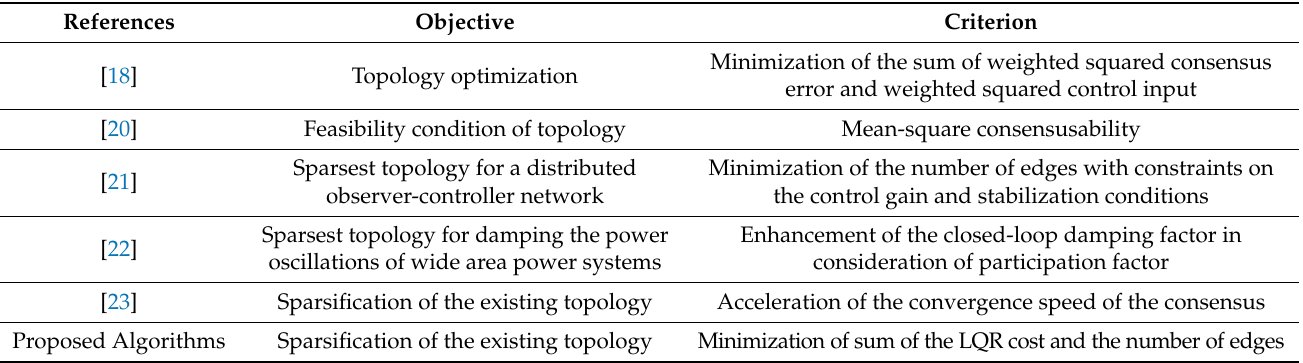
Table 1. The objective and the criterion in existing